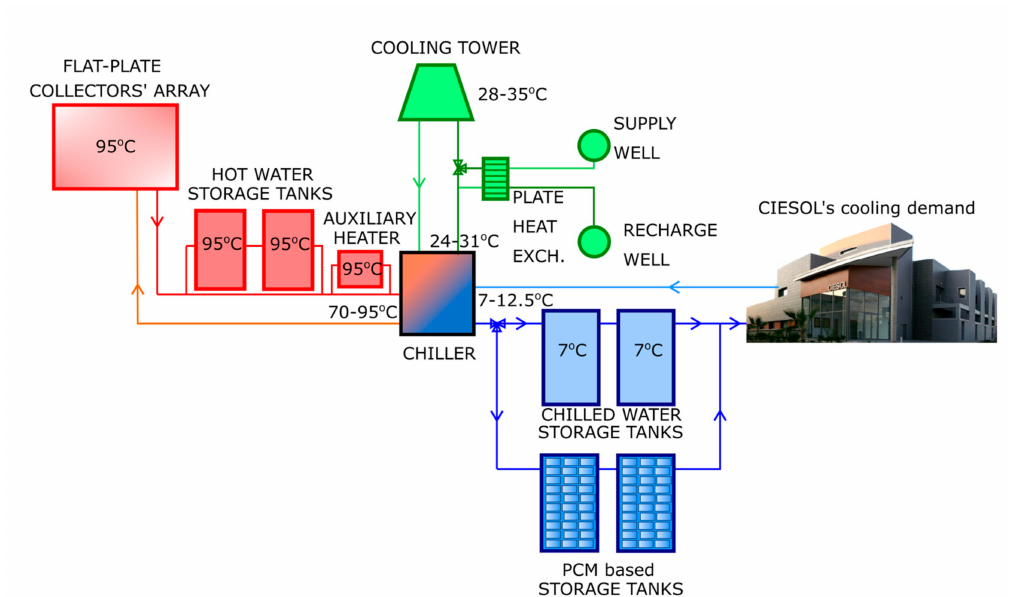
Figure 1. The heating and cooling installation of the CIESOL building (Almeria), using storage tanks with phase change materials (PCMs) or chilled